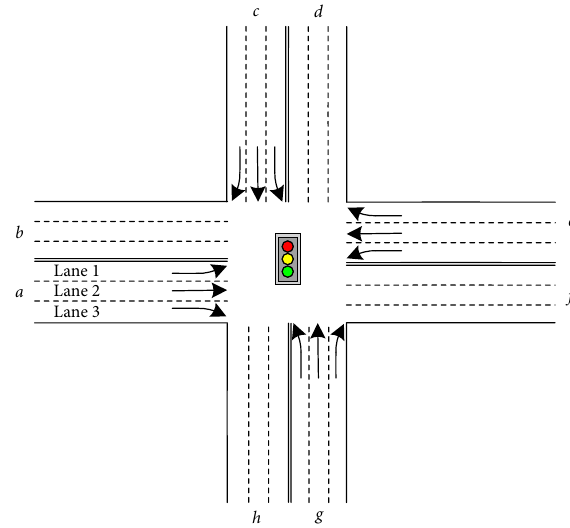
Figure 2. Intersection with four traffic